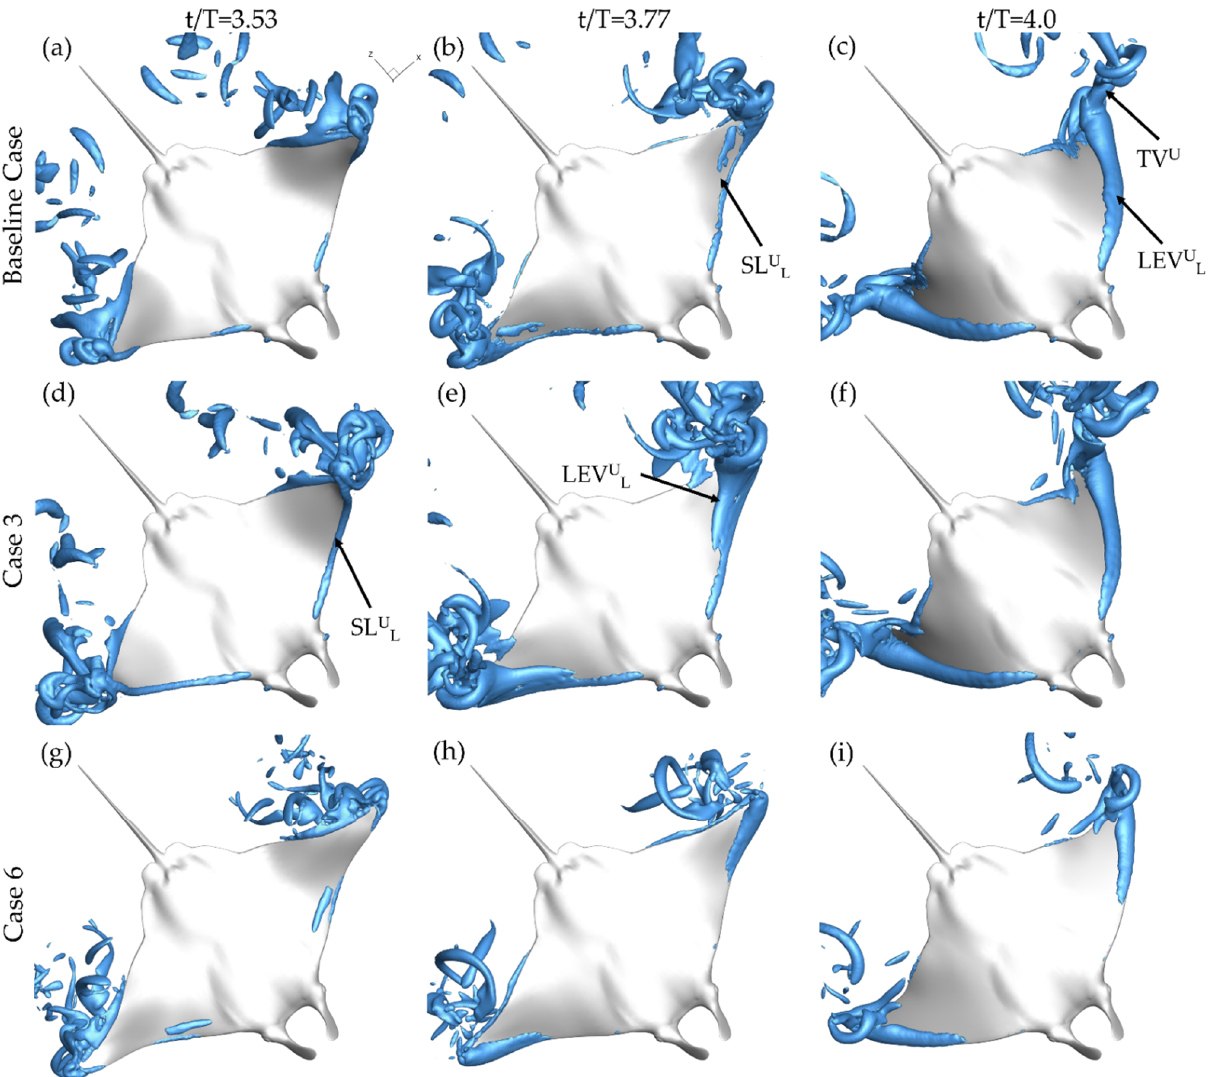
Figure 8. Perspective views of upstroke vortex formation for the baseline case (BR = 1.0 PR = 1.0) ( a – c ) case 3 (BR = 1.0 PR = 0.50) ( d – f ) and case 6 (BR = 0.5 PR = 1.0) ( g – i ) at t/T = 3.53 ( a , d , g ) t/T = 3.77 ( b , e , h ) and t/T = 4.0 ( c , f , i